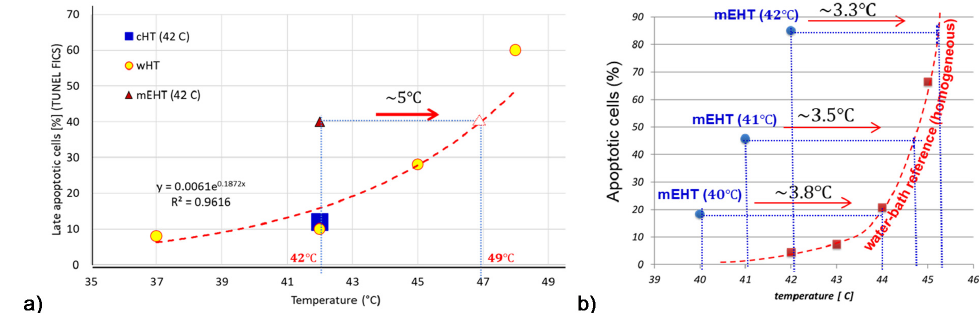
Figure 9. The calibration of the thermal factor of mEHT. ( a ) The homogeneous HT (water-bath hyperthermia, wHT) is used to calibrate apoptosis. The mEHT causes effective apoptosis at 42 ◦ C, corresponding to the calibration at 5 ◦ C higher (HepG2 cell-line) [133]. The mEHT affects the rafts on the cell-membrane with a 5 ◦ C higher temperature than the average medium indicates. ( b ) Another calibration measurement with the U937 cell line [95,136]. The mEHT shows a >3 ◦ C temperature difference in apoptotic efficacy at all measured points. A critical thermal factor is that the possible touching point of two cells has a drasti- cally increased heat-production due to the extensive SAR at that point [105]. The telophase